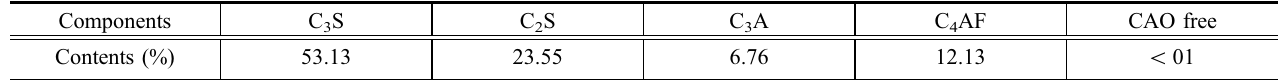
Table 3 Mineralogical composition of clinker.